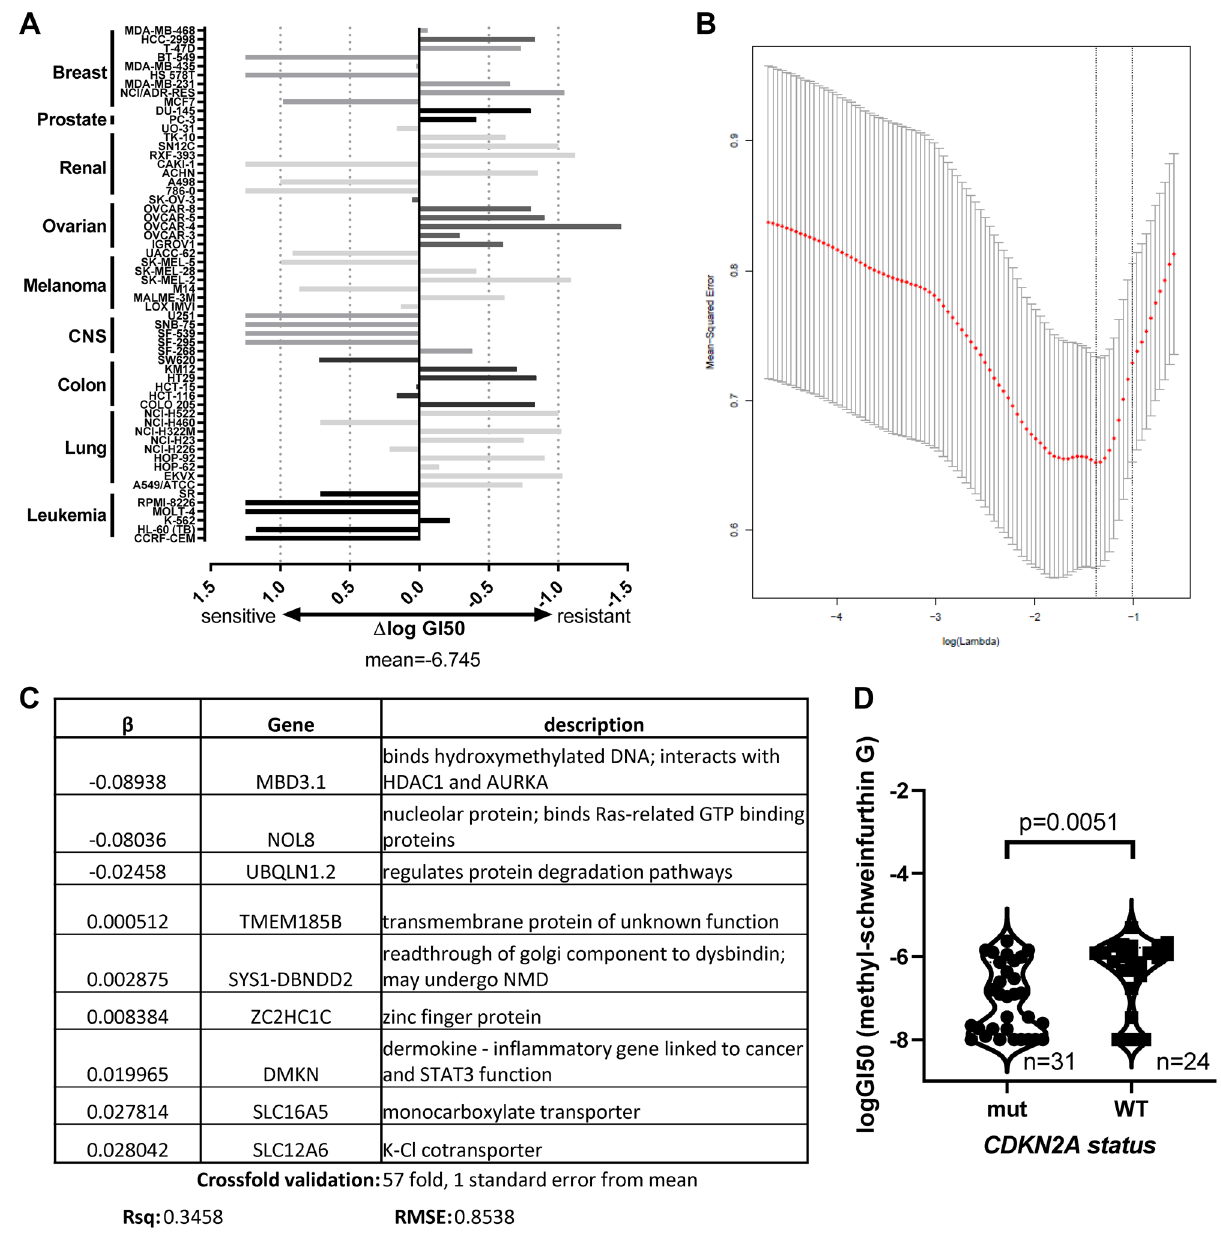
Figure 2. NCI-60 gene expression and schweinfurthin sensitivity. ( A ) Sensitivity of NCI-60 cell lines to MG, expressed as ΔlogGI50(molar) from the mean (− 6.745). Data was obtained through the NCI-60 screening program. ( B ) Lambda vs MSE plot for leave one out crossfold validation of LASSO regression. ( C ) LASSO regression significant genes with β values for leave one out crossfold validation of LASSO regression. Five- and ten-fold cross-validation methods for LASSO regressions were also employed for the same data set and are presented in Supplementary Fig. 1A,B. ( D ) CDKN2A mutations significantly correlate (p = 0.0051) with MG sensitivity as shown by log 10 GI50(M). Other known cancer driver mutations were not significantly correlated with sensitivity and are profiled in Supplementary Fig.